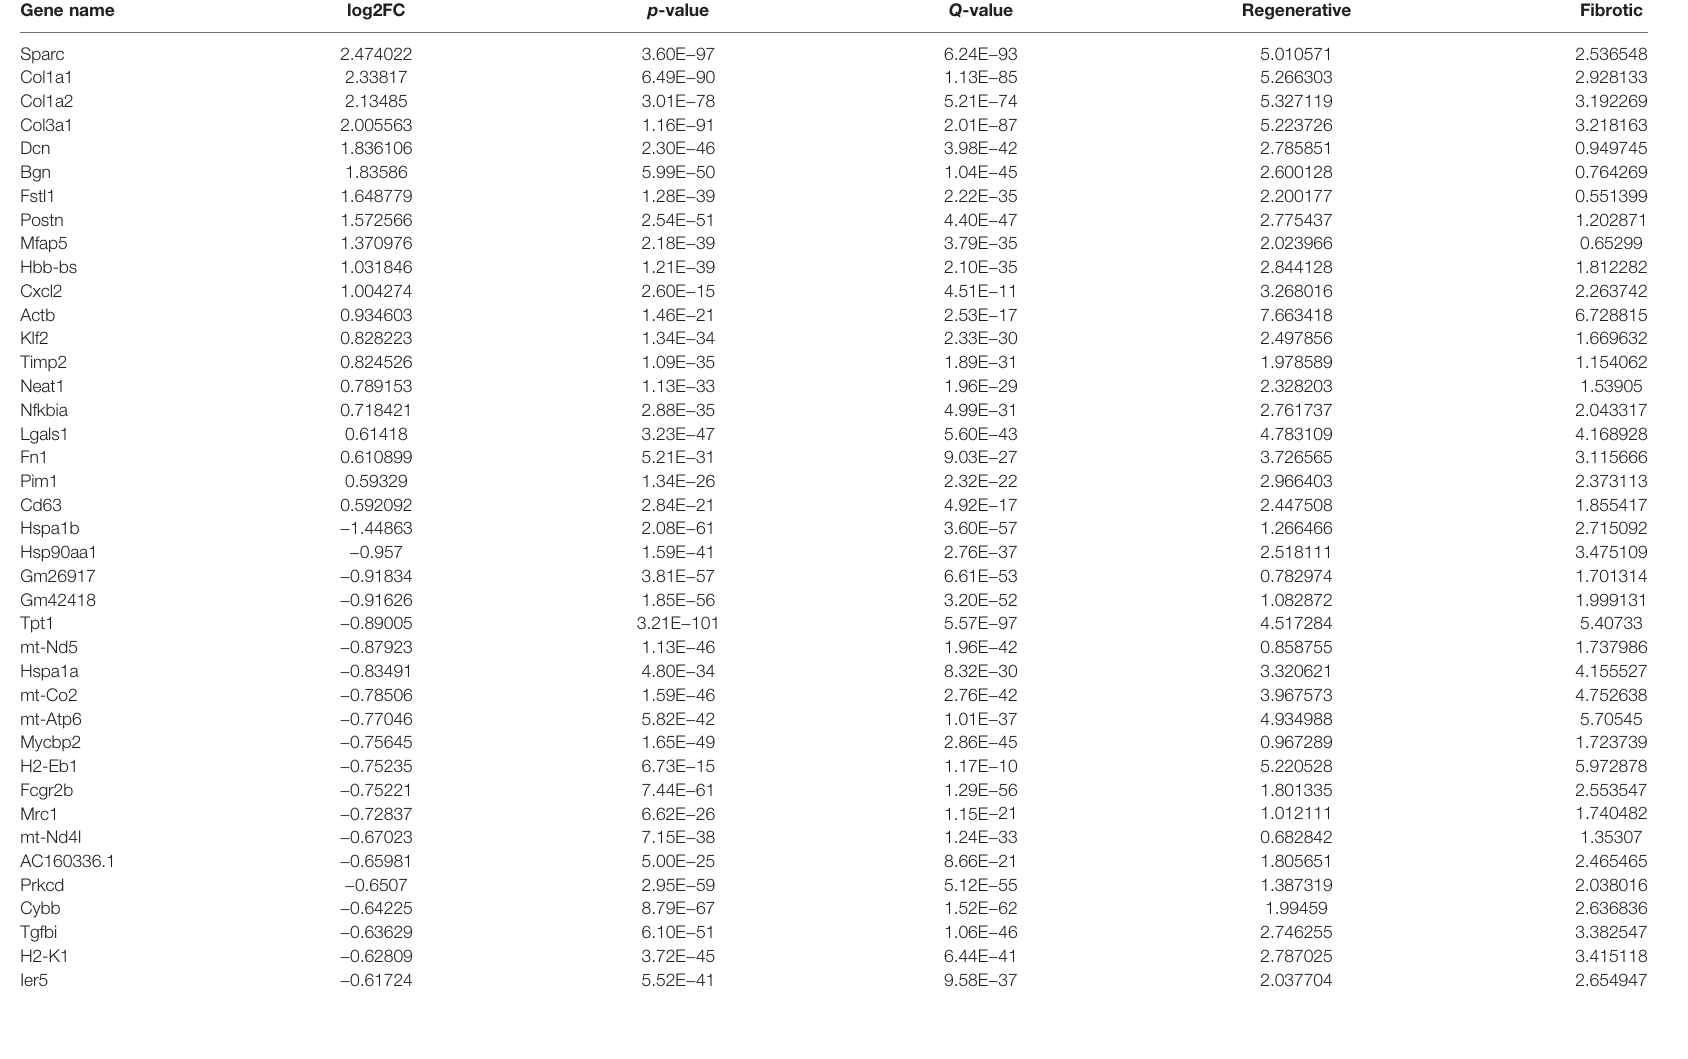
TABLE 3 | The fi rst 20 up- and downregulated speci fi c genes between fi brotic and regenerative